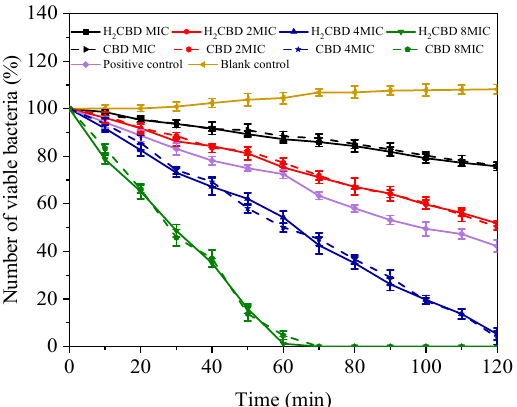
Figure 3. Time–kill kinetics curves of S. aureus under treatment of minimum inhibitory concentration (MIC), 2 × MIC, 4 × MIC, and 8 × MIC of H 2 CBD, CBD. 2.5. H 2 CBD Possess Similar Toxicity towards to Human Skin Fibroblasts as CBD